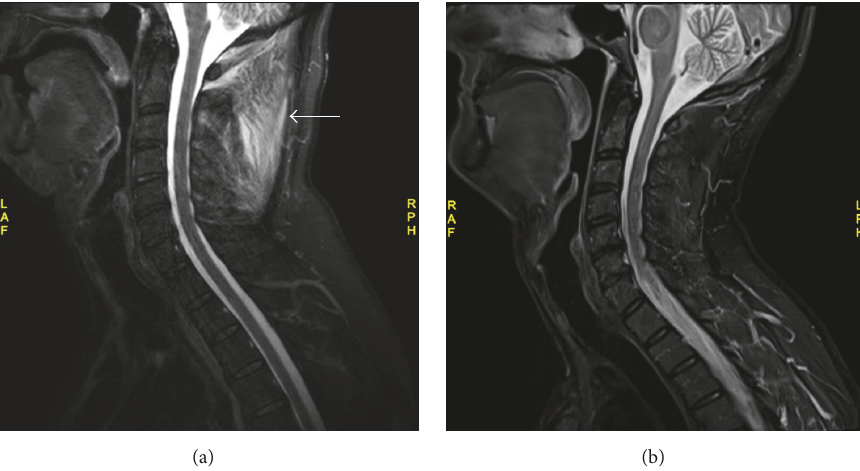
Figure 1: (a) T2-weighted sagittal MRI of neck pretreatment, showing hyperintensity in the posterior paraspinal muscles, consistent with myositis (arrow). (b) T2-weighted sagittal MRI of neck following six weeks of antibiotic treatment, showing complete resolution of